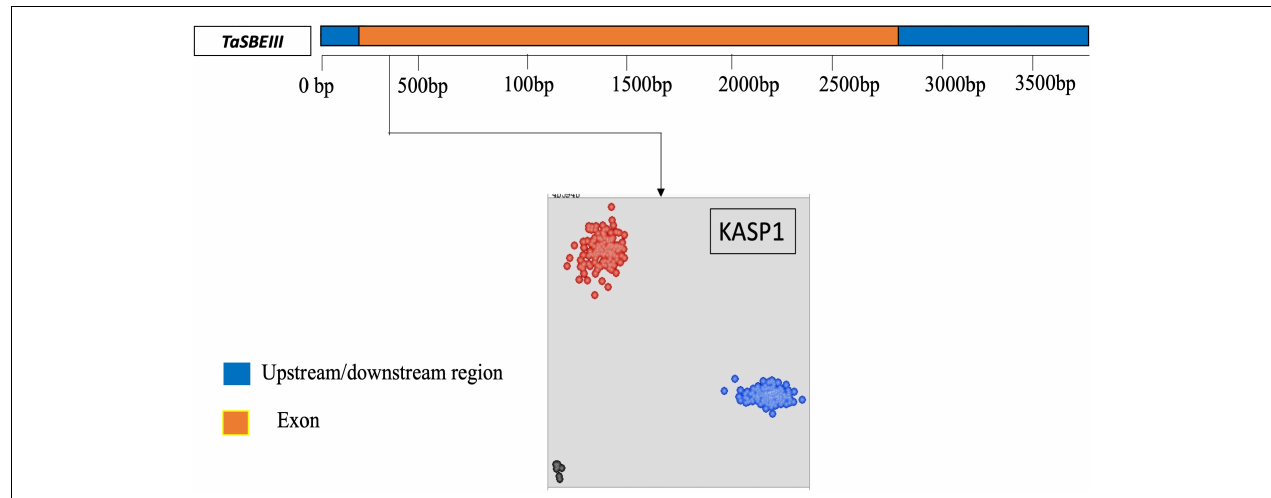
FIGURE 2 | Gene structure and developed KASP marker for TaSBEIII-A . Gene structure of TaSBEIII-A consists of an upstream and downstream region with blue color and orange blocks representing the exon region. Bp represents the base pairs. The clusters of accessions are represented on the scatter plot on the x -axis (FAM) and y -axis (HEX). Accessions with blue color represent the FAM type of allele C while accession in red color denotes the Hex type of allele T . Black dots represent the non-template control (NTC).